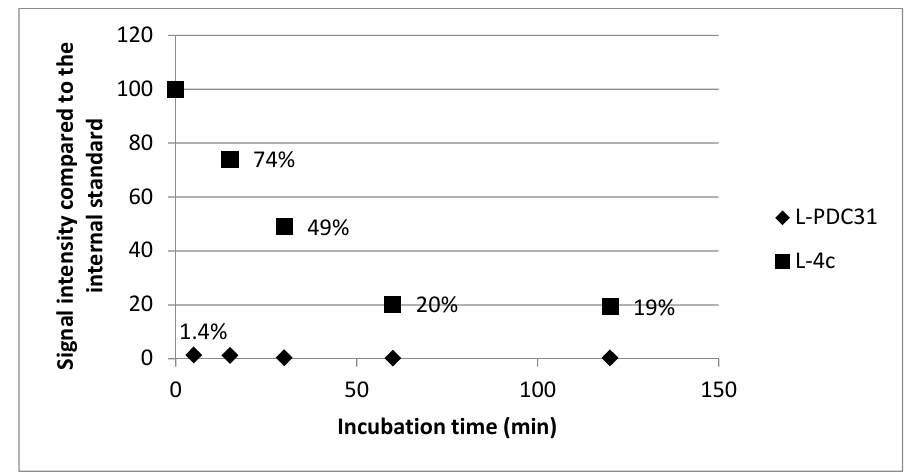
Figure 3. Intensity of MS signal of L ‐ PDC31 and L ‐ 4d compared to the internal standard L ‐ 4f as a function of incubation time in mouse plasma.